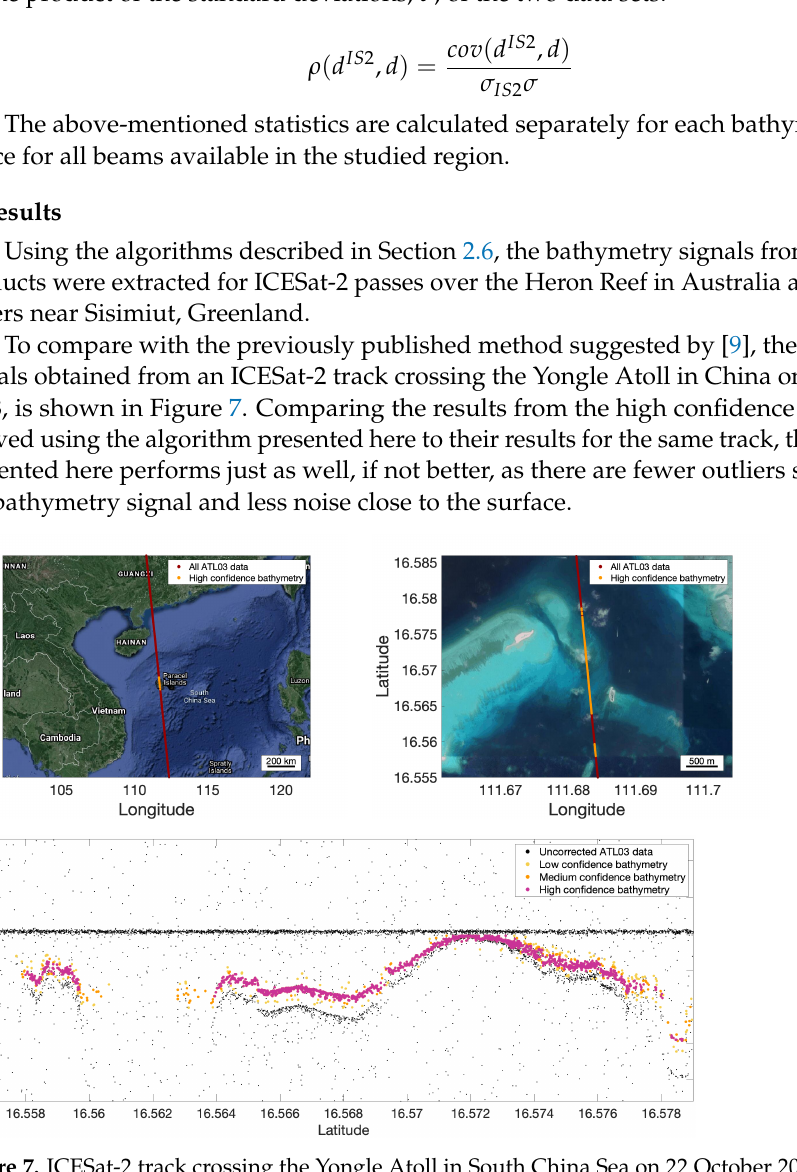
Figure 7. ICESat-2 track crossing the Yongle Atoll in South China Sea on 22 October 2018. The beam shown in this plot is gt3r. ( Top left ) Location of the Yongle Atoll in the South China Sea, ( Top right ) Location of beam gt3r across the Yongle Atoll, and ( bottom ) the derived bathymetry signal compared to uncorrected ATL03